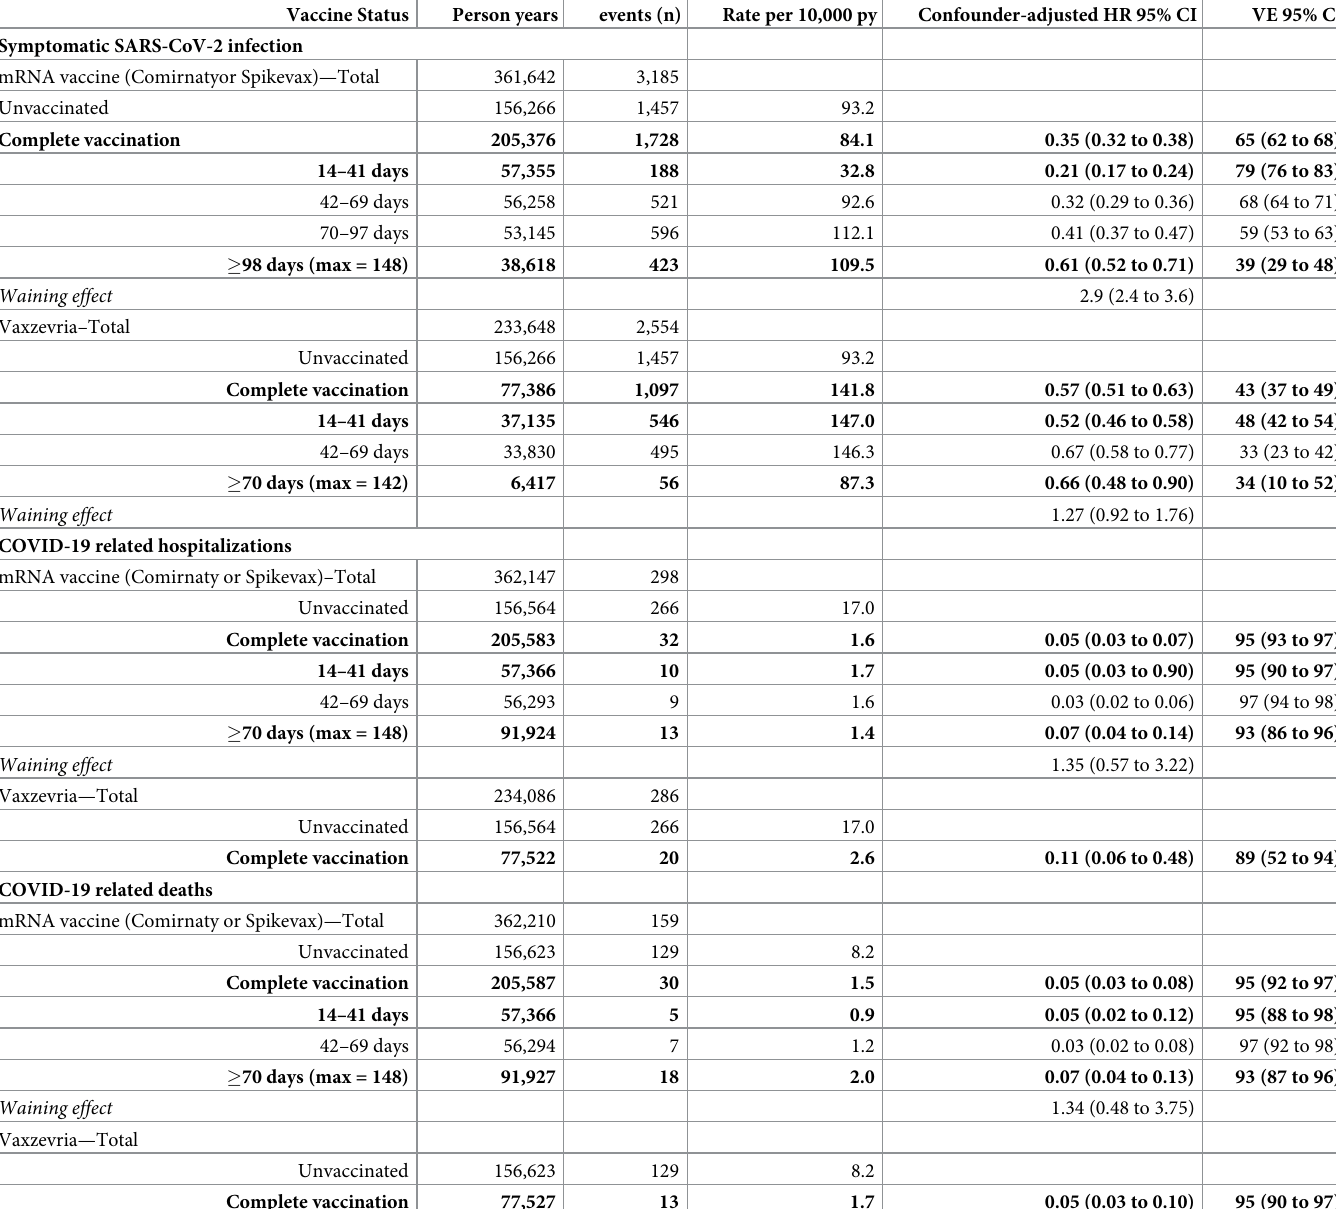
Table 1. Symptomatic SARS-CoV-2 infection, COVID-19 related hospitalizations and deaths, incidence, hazard ratios and vaccine effectiveness by mRNA (Comir- natyor Spikevax) and Vaxzevria vaccination status for individuals aged 65–79 years, Portugal, March–September 2021 (n =